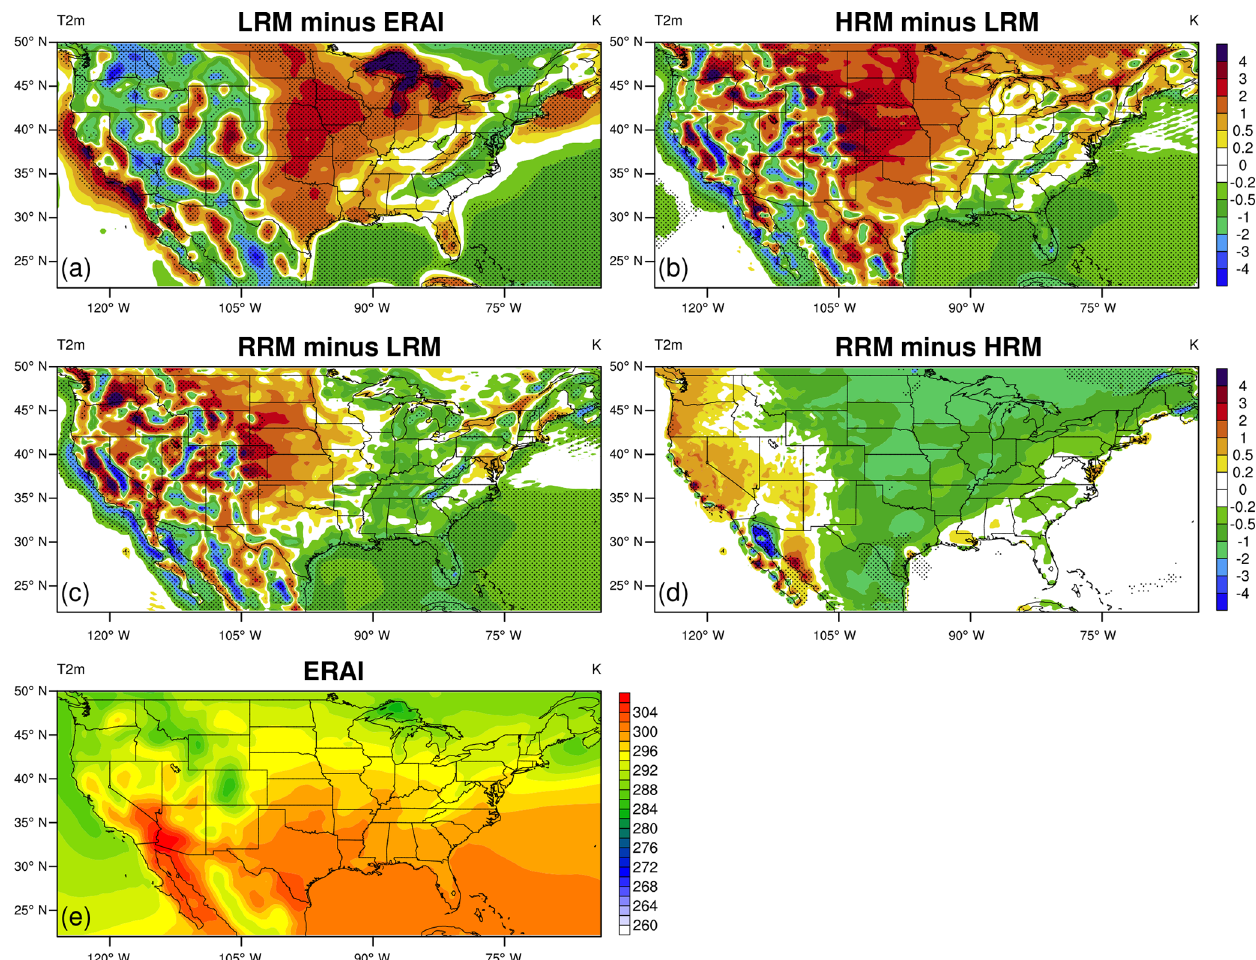
Figure 10. Same as Fig. 4, but for 2m air temperature ( T 2m , unit: K) in